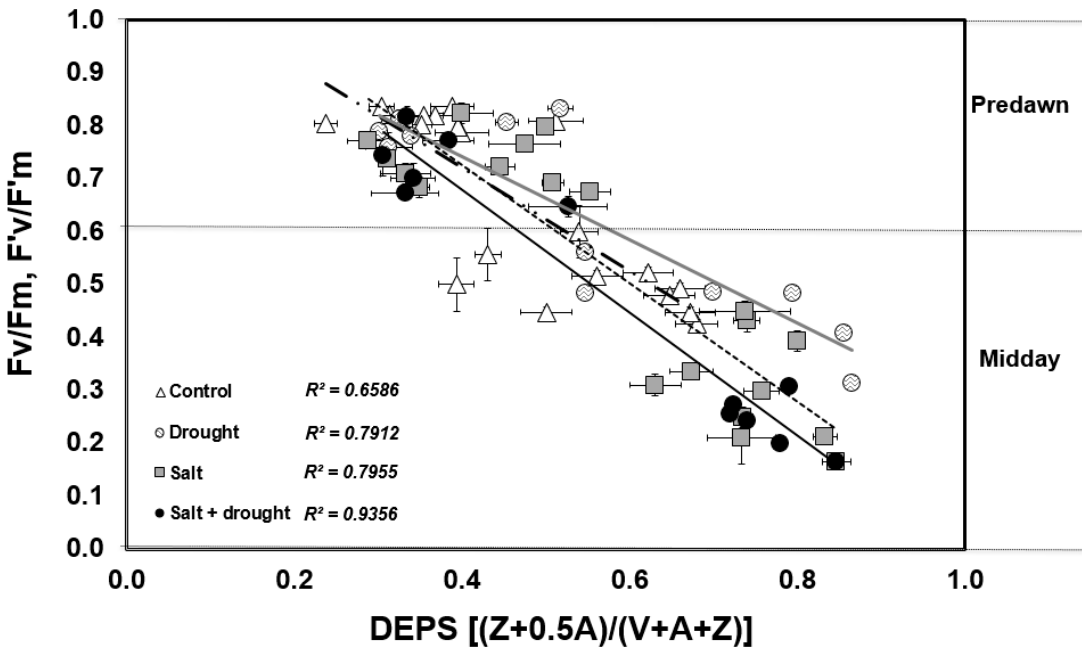
Figure 5. Correlation between photosynthetic efficiency (Fv/Fm= Predawn, F’v/F’m = Midday) and xanthophyll cycle (DEPS).